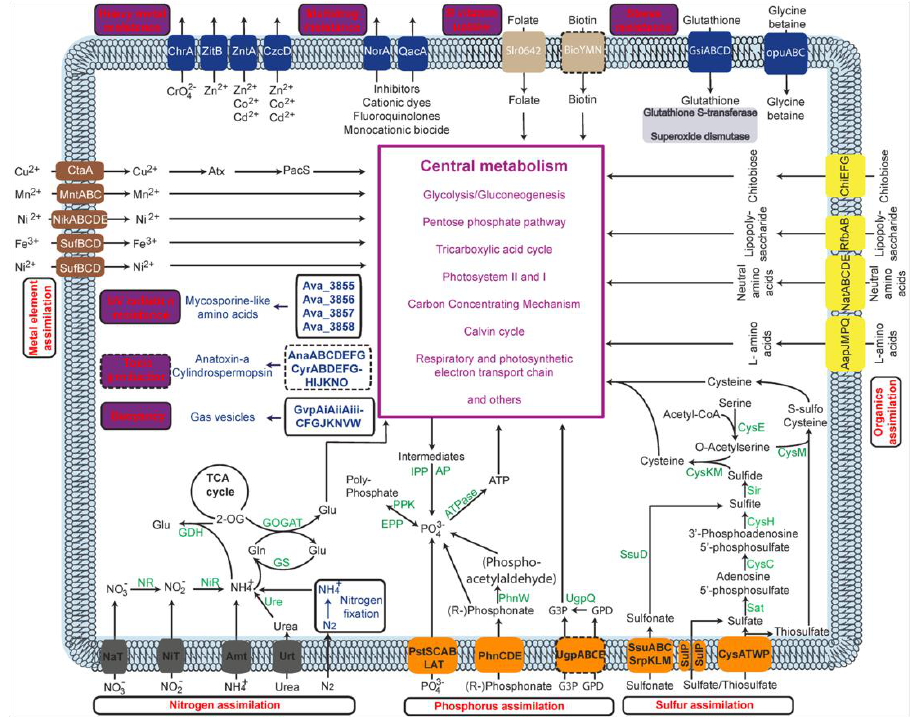
Figure 2. The core and query pathways in Aphanizomenon flos-aquae NIES-81. The pathways labeled with dashed borders are not complete (due to the absence of required components) in this strain but may be complete in others.